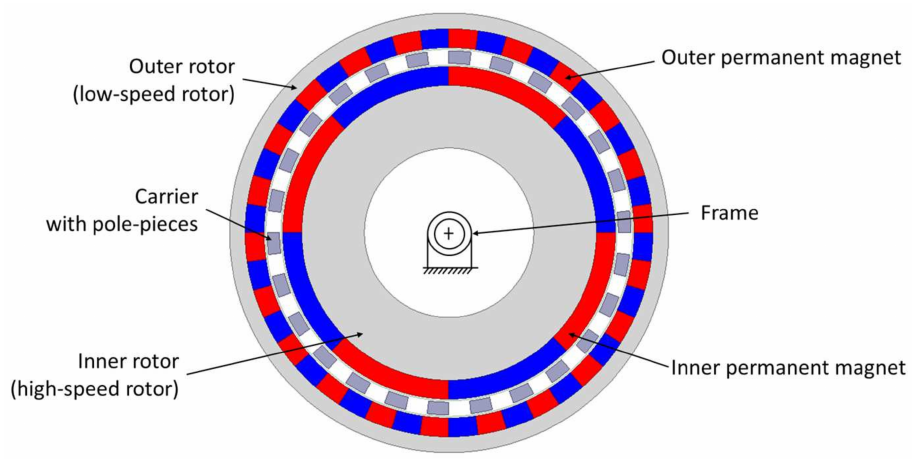
Figure 1. Cross-sectional view of